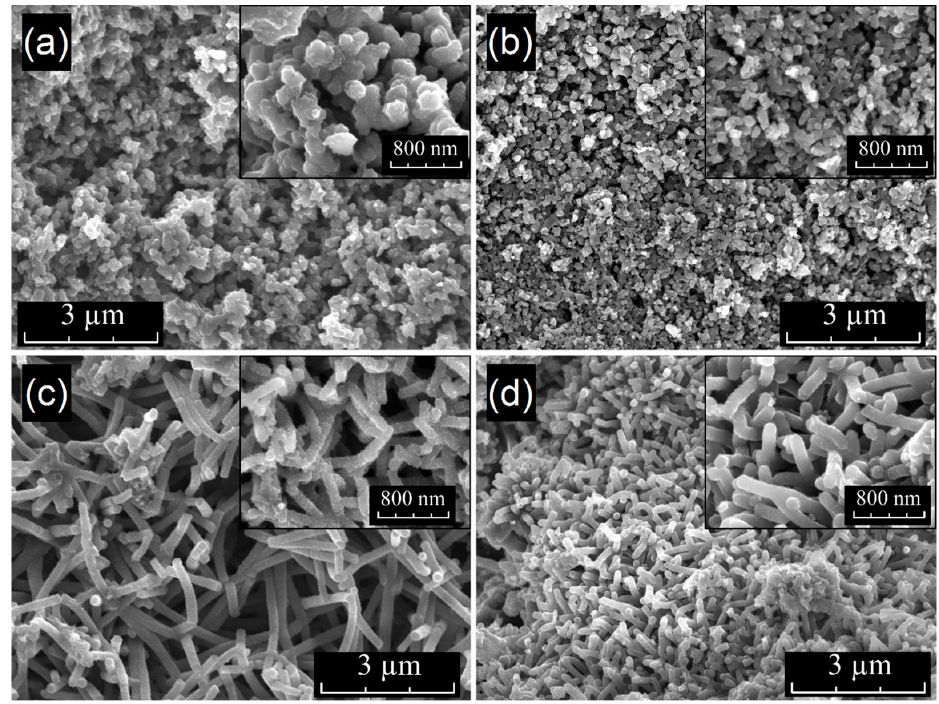
Figure 1. SEM images of ( a ) PANI-R (scale bar 3 μ m), ( b ) PANI-R-900 (scale bar 3 μ m), ( c ) PANI-T (scale bar 3 μ m), and ( d ) PANI-T-900 (scale bar 3 μ m). The insets present SEM images acquired at (scale bar 3 µ m), and ( d ) PANI-T-900 (scale bar 3 µ m). The insets present SEM images acquired at higher magnification with a scale bar of 800 nm. higher magnification with a scale bar of 800